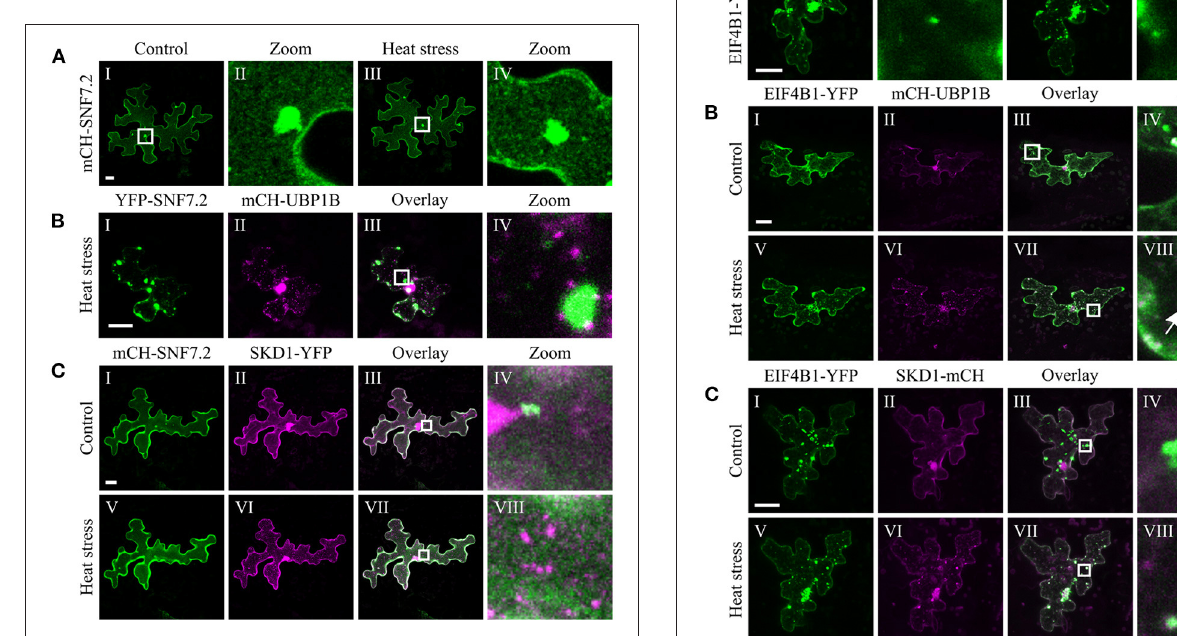
FIGURE 6 | Subcellular localization of SNF7.2 before and after heat stress. Representative images of CLSM stacks (maximum projections) of leaf epidermal cells single or double transformed with constructs overexpressing ( 35S promoter) SNF7.2. The results are summarized in Table 3 . The same cells were imaged before and after heat stress. For clarity, SNF7.2 is shown in green and UBP1b and SKD1 are depicted in magenta, independent of the fluorescent tag. Scale bar = 20 µ m. (A) mCH-SNF7.2, (B) YFP-SNF7.2 with mCH-UBP1B, (C) mCH-SNF7.2 with SKD1-YFP.